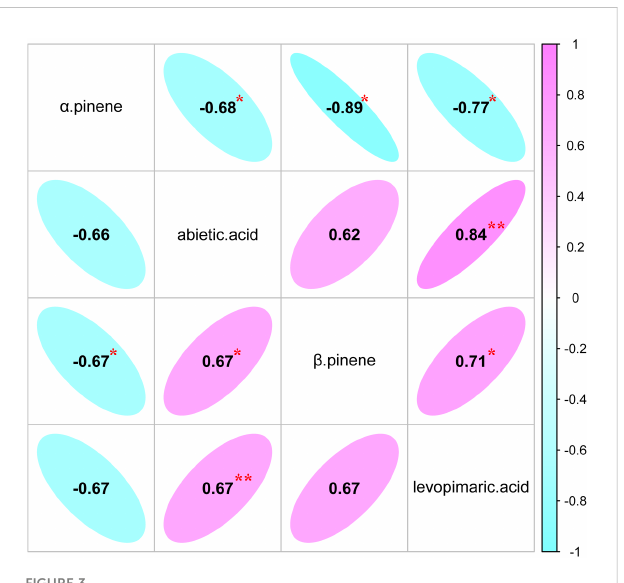
FIGURE 3 Estimates of genetic correlation (below the diagonal) and phenotypic correlation (above the diagonal) of different resin components.